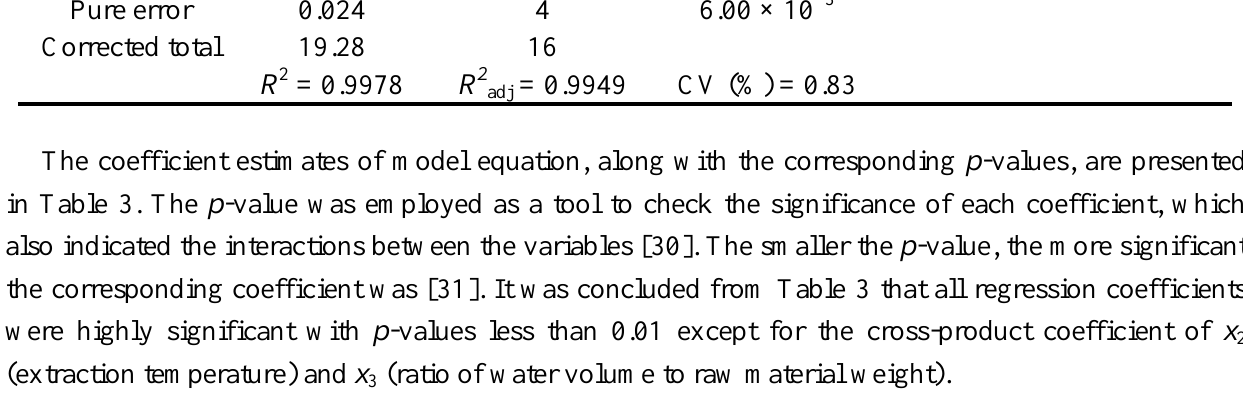
Table 3. Regression coefficient estimates and their significance test of quadratic polynomial